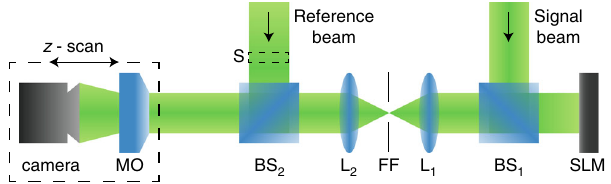
Fig. 4 Experimental setup. Nd:YVO 4 laser source, cw, wavelength λ 0 = 532 nm. SLM spatial light modulator, BS beam splitter, L lens, FF Fourier fi lter, MO microscope objective, S